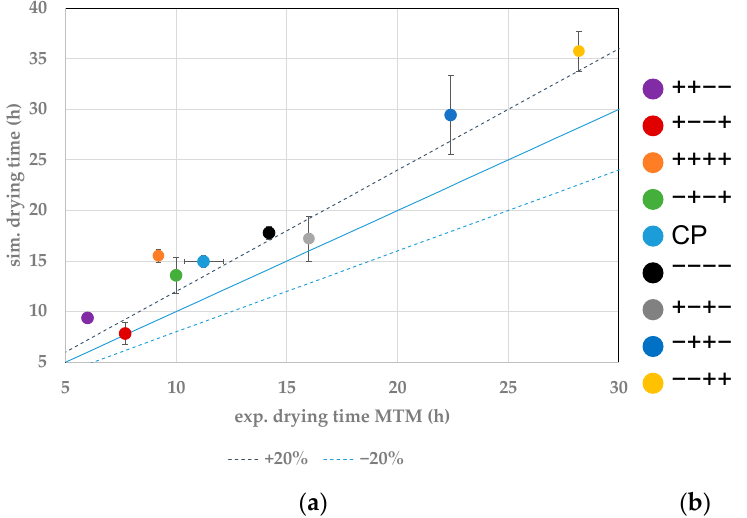
Figure 9. ( a ) Parity plot between simulated and experimental primary drying endpoints of MTM. ( b ) Color legend.